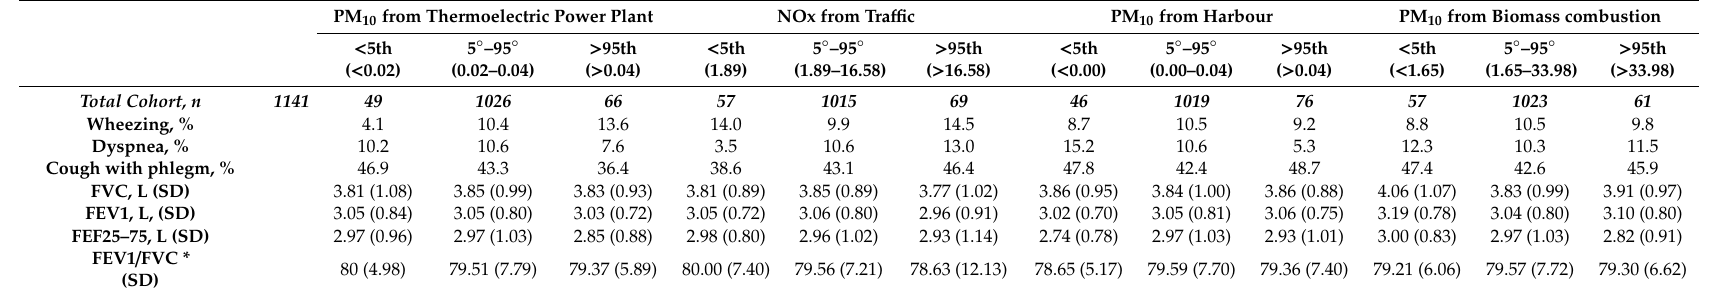
Table 2. Respiratory symptoms and lung function by level of exposure.